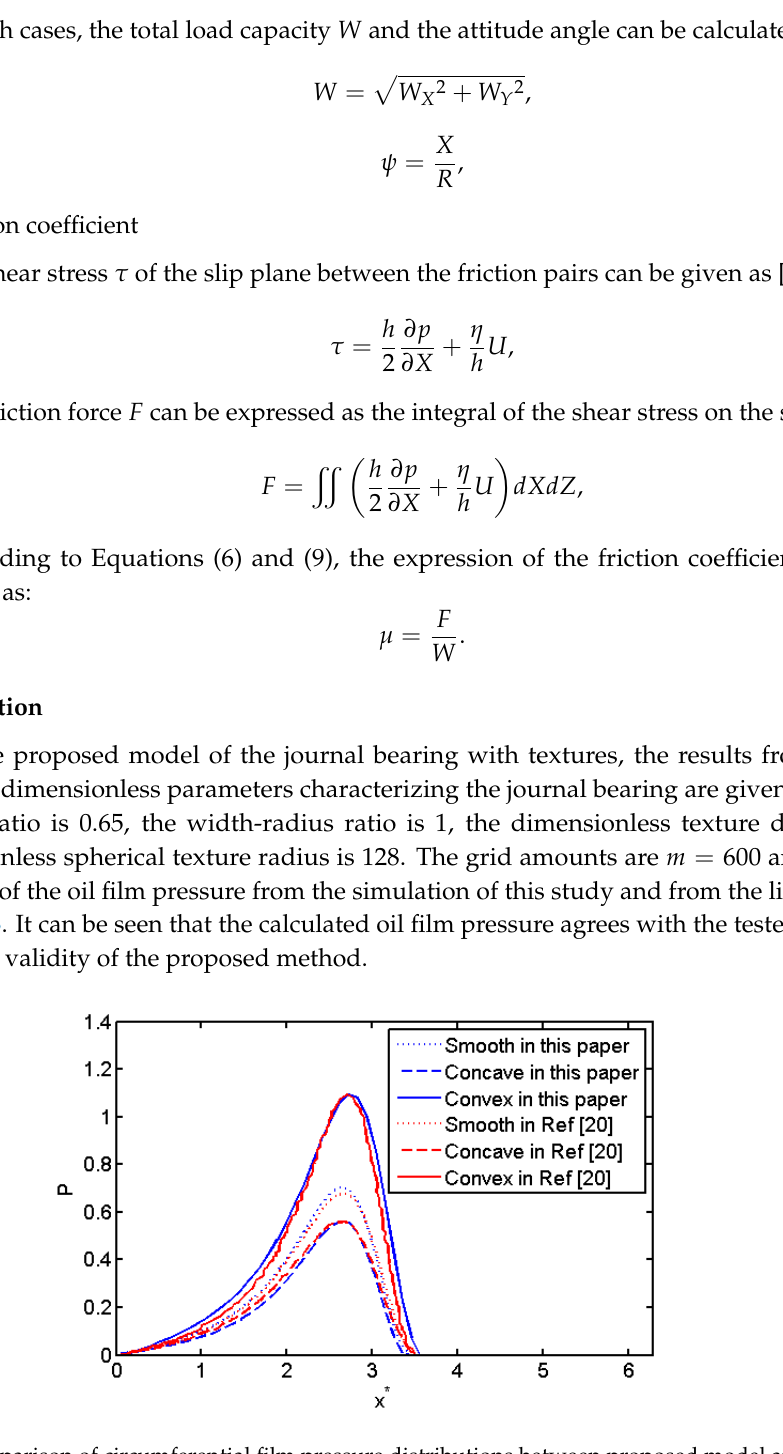
Figure 3. Comparison of circumferential film pressure distributions between proposed model and [20].